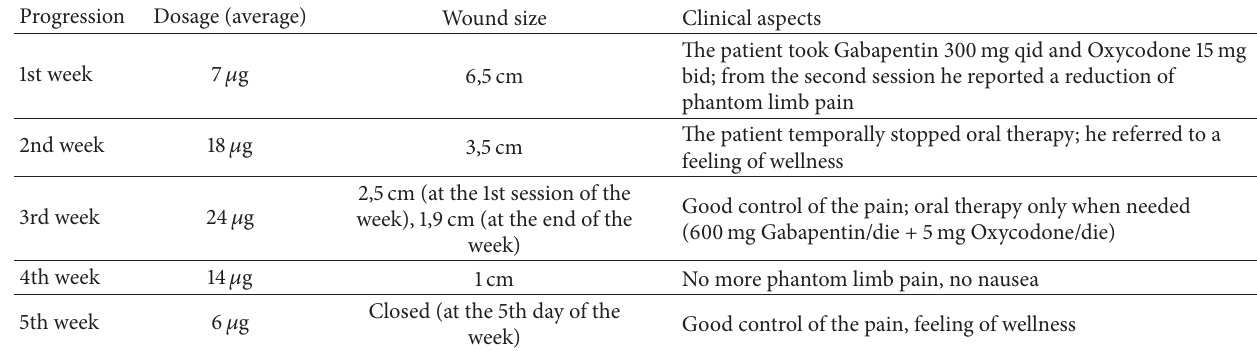
Table 1: Progression, dosage, and clinical aspects of the